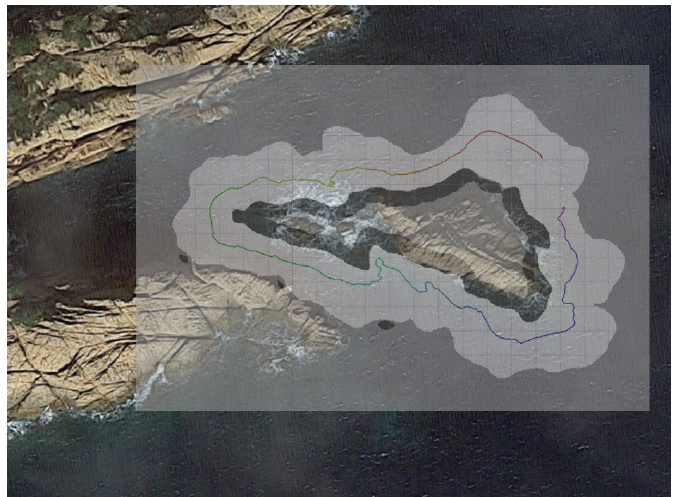
Figure 20. Rocks HM superimposed with a satellite image (source: Map data c (cid:13) 2018 Google, Inst. Geogr. Nacional, Spain).